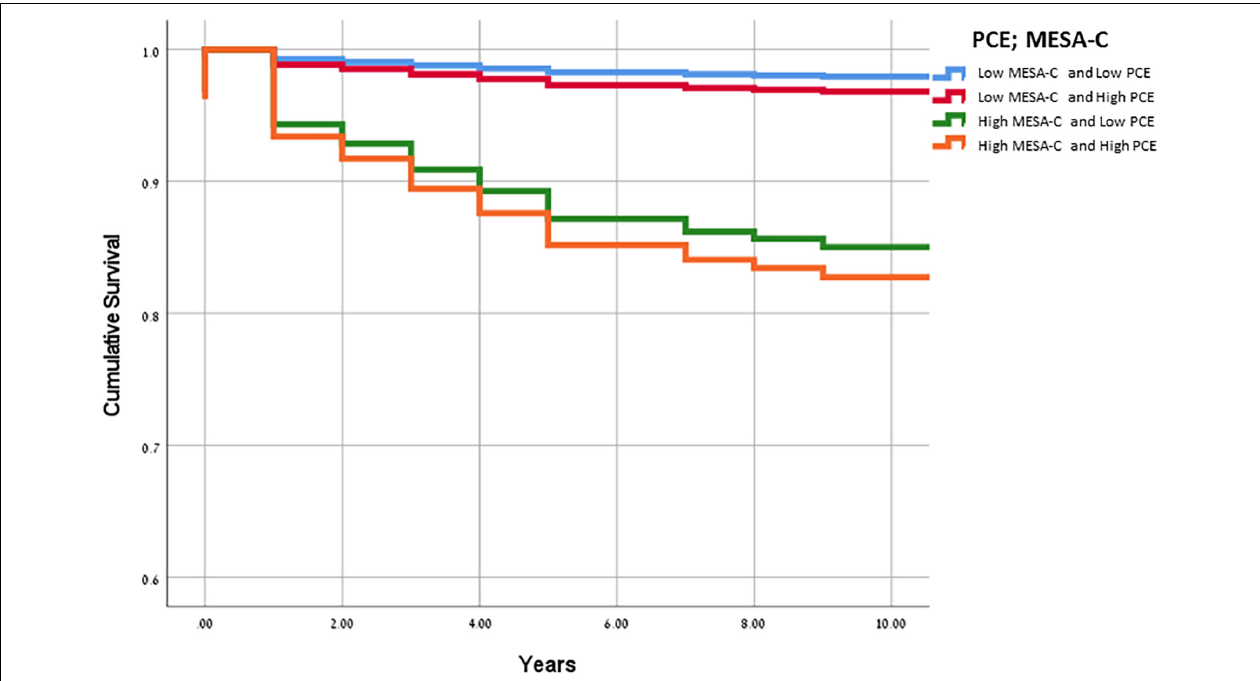
FIGURE 1 | Kaplan-Meier curves for cumulative survival according to the cardiovascular risk score classification. The blue line denotes low MESA-C and PCE risk categories ( ≤ 7.5% for both), the red line denotes low MESA-C risk ( ≤ 7.5%) and high PCE risk ( > 7.5%), the green line denotes high MESA-C risk ( > 7.5%) and low PCE risk ( ≤ 7.5%), and the orange line denotes high MESA-C and high PCE risk categories ( > 7.5% for both). PCE, pooled cohort equations; MESA, multiethnic study of